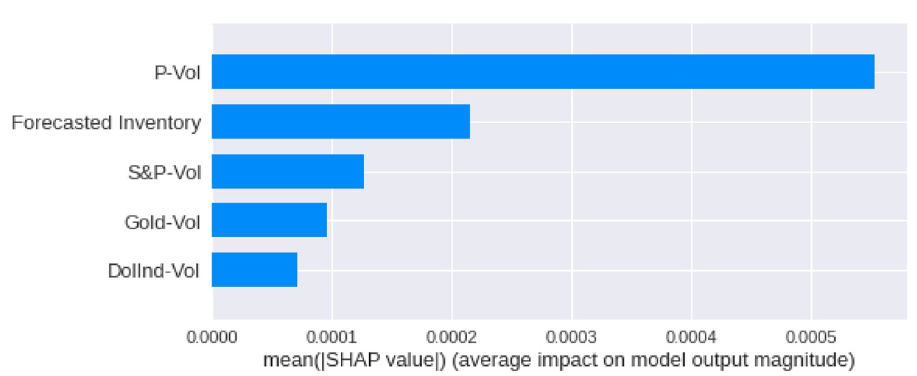
Fig 20. Mean Shapley values for the second previous day using Nadam optimizer.